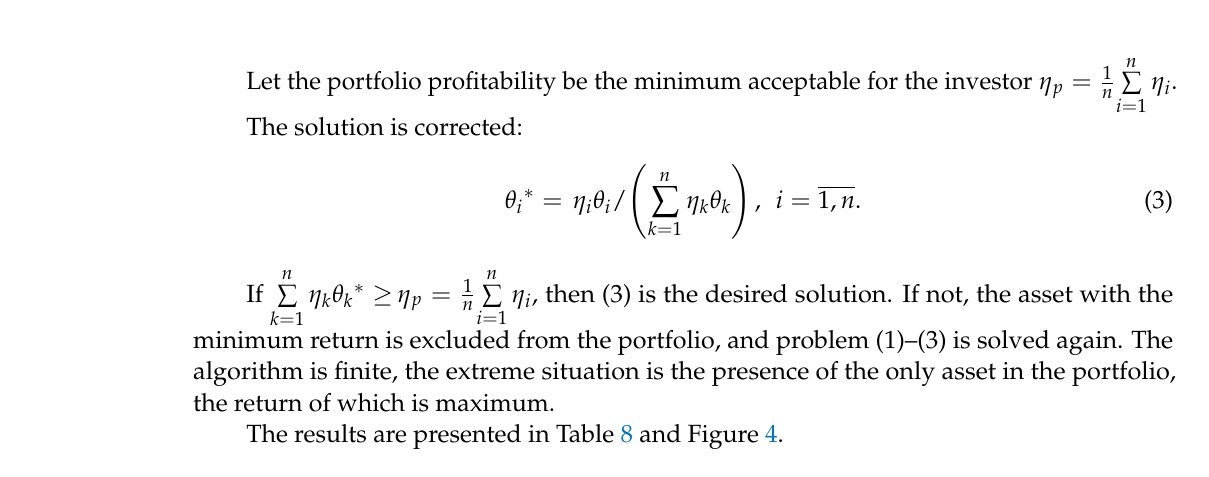
Table 8. Financial analysis of companies (shares in the portfolio).